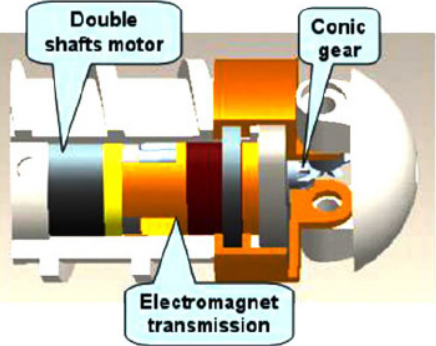
Figure 5. Swimming robotic capsule endoscopy. Adapted from Liu et al. [25] with permission from IEEE.